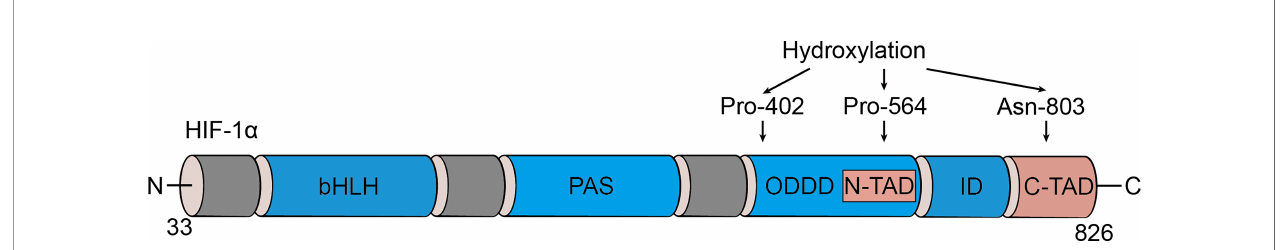
FIGURE 1 | Domain structure of HIF-1 a . HIF-1 a is comprised of several conserved domains including a DNA binding (basic helix-loop-helix, bHLH) domain, protein/ protein interactions and dimerization (PAS) domain, C-terminal trans-activation domain (C-TAD), N-terminal trans-activation domain (N-TAD), oxygen-dependent degradation domain (ODDD), and inhibitory domain